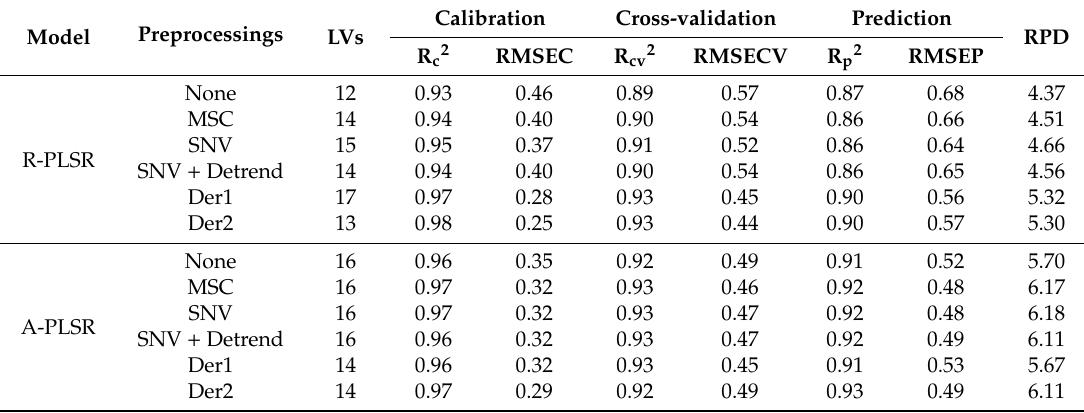
Table 1. Summary of partial least squares regression (PLSR) model results based on raw and preprocessed full R, A, and KM spectra.